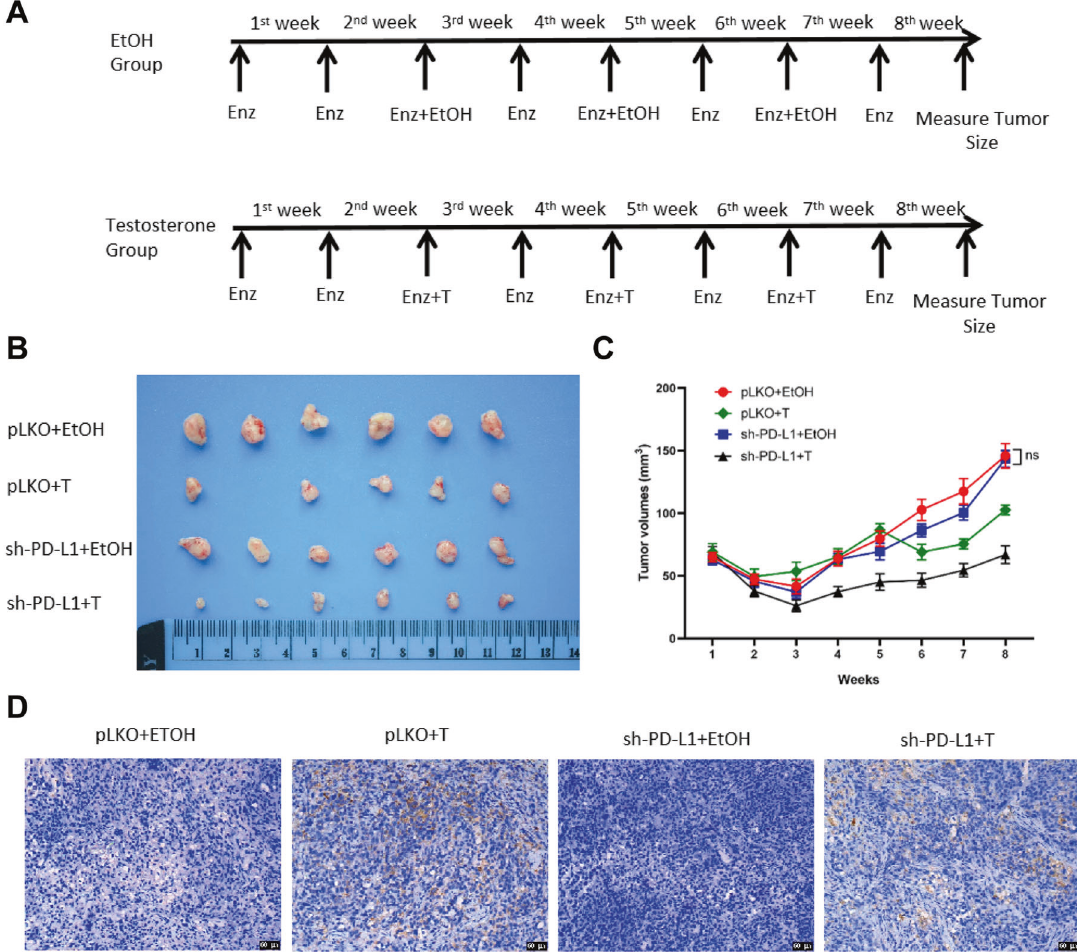
Fig. 7 A lower PD-L1 expression can enhance high dose androgen ’ s suppression of tumor growth in vivo. A Treatment schecule of nude mice groups injected with EnzR1-C4-2 cells transfected with pLKO or sh-PD-L1 at suspension of 5 × 10 6 cells. Mice were injected with Enz (10 mg/kg, twice weekly). Bipolar therapy treatment was conducted by injection of Testosterone (200 μ g/kg, twice weekly) or EtOH (Ethanol) during the 3rd/5th/7th week. Mice were sacri fi ced after 8 weeks, tumors were removed and measured for studies. B , C Xenograft tumors from mice after eight weeks ’ drug treatment are shown. Knocking down PD-L1 B increases high dose androgen sensitivity and decreases xenograft tumor size. Tumor sizes were measured every week to calculate tumor volumes ( C ), with reduction of the xenografts observed in sh-PD-L1 plus Testosterone treatment group. D Representative IHC images of PD-L1 expression in tumor tissue samples from the four groups, 200× magni fi cation. NS Not Signi fi cant.